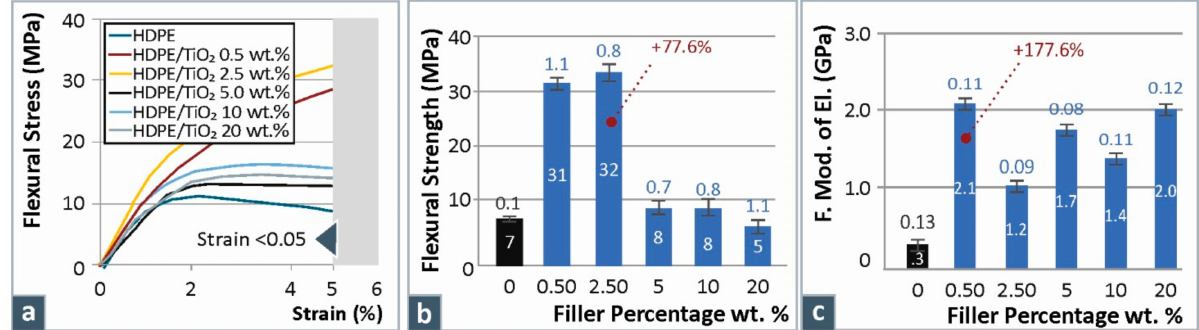
Figure 3. Overall ( a ) flexure stress vs. strain graphs for HDPE/TiO 2 , ( b ) comparative flexure strength graph, and ( c ) flexural mod. of elasticity for all the materials studied.